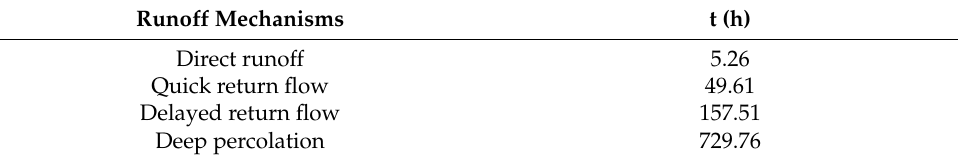
Table 4. Storage time for the main runoff mechanisms detected in the Ciciriello catchment.